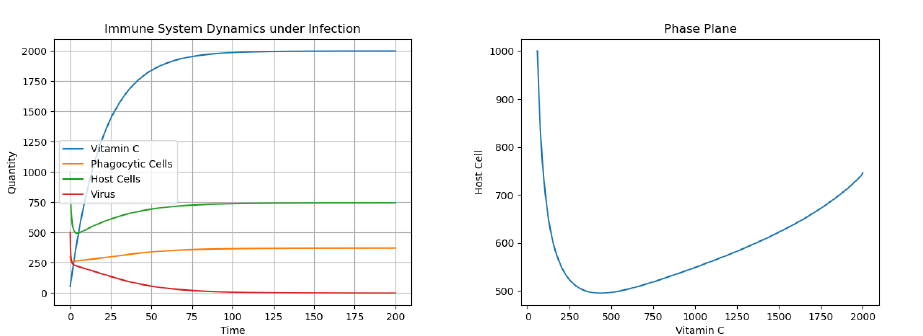
Figure 7. Dynamics under Frustrated Phagocytosis with Extreme Constant Infusion of Vitamin